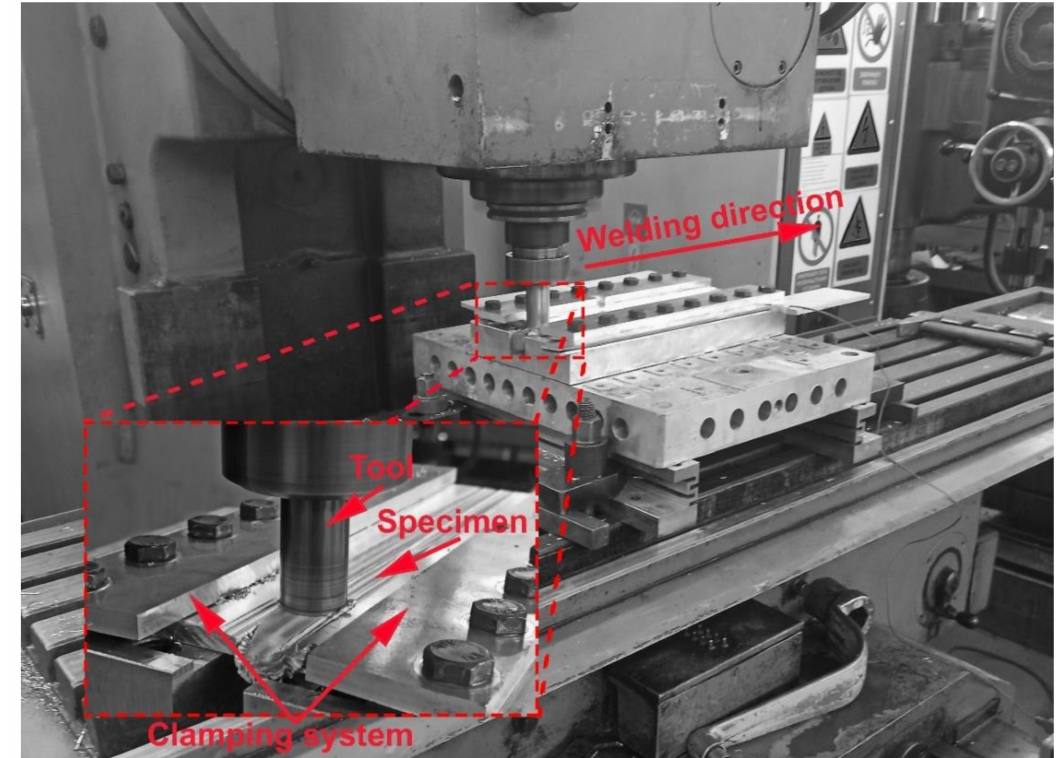
Figure 3. Bobbin friction stir welding process set-up.